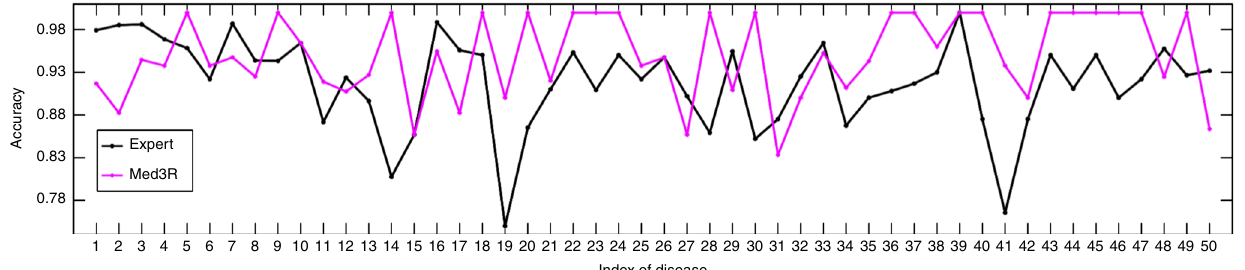
Fig. 4 Accuracy comparison between the Med3R system and medical experts. The accuracy of expert listed here is the average accuracy of four medical experts (Details about the annotation accuracy of four medical experts is given in the Supplementary Fig. 10) over 50 diseases (see Supplementary